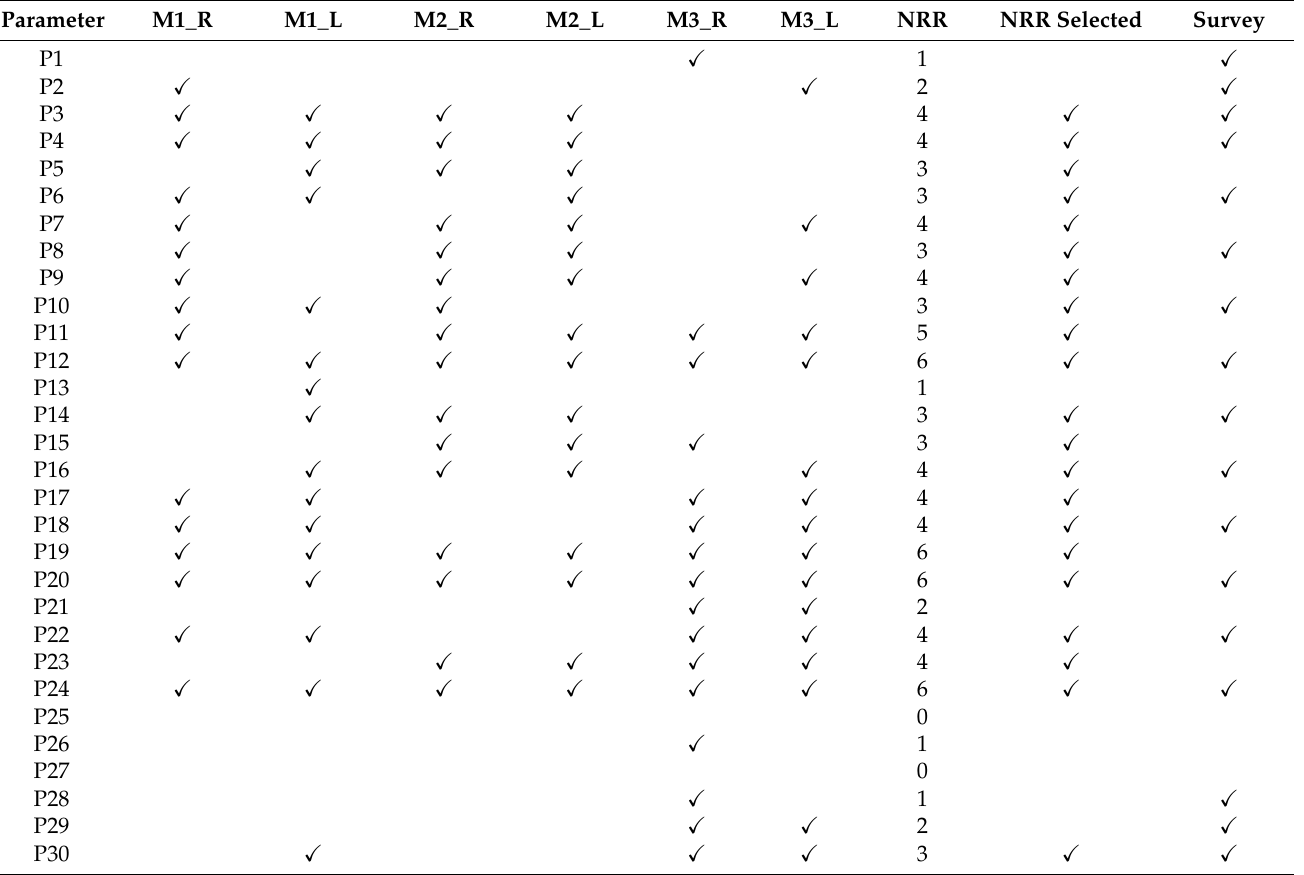
NRR—number of repetitive results, M1_R/M1_L—parameter selection due to percentage distribution of parameters out of normal for right (R)/left (L) upper limb; M2_R/M2_L—parameter selection due to differences in mean values between reference and patient groups for right (R)/left (L) upper limb; M3_R_RG/M3_L_RG/M3_R_PG/M3_L_PG—parameter selection due to variation in parameters for the right (R)/left (L) upper limb, in the reference group (RG) and the stroke group